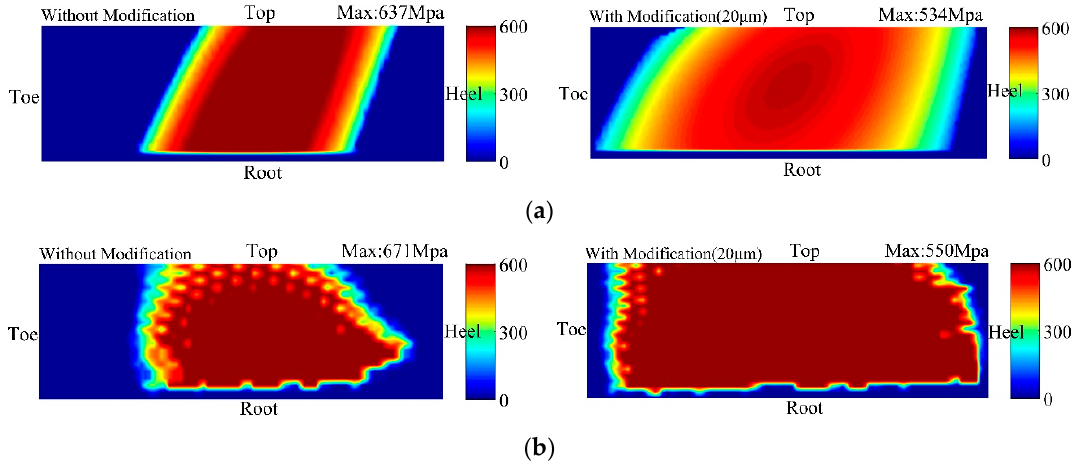
Figure 5. ( a ) The contact pattern of TCA with and without modification of Case 4; ( b ) The contact pattern of LTCA with and without modification of Case 4 (Reprinted with permission from [43]. Copyright 2018 SAGE).